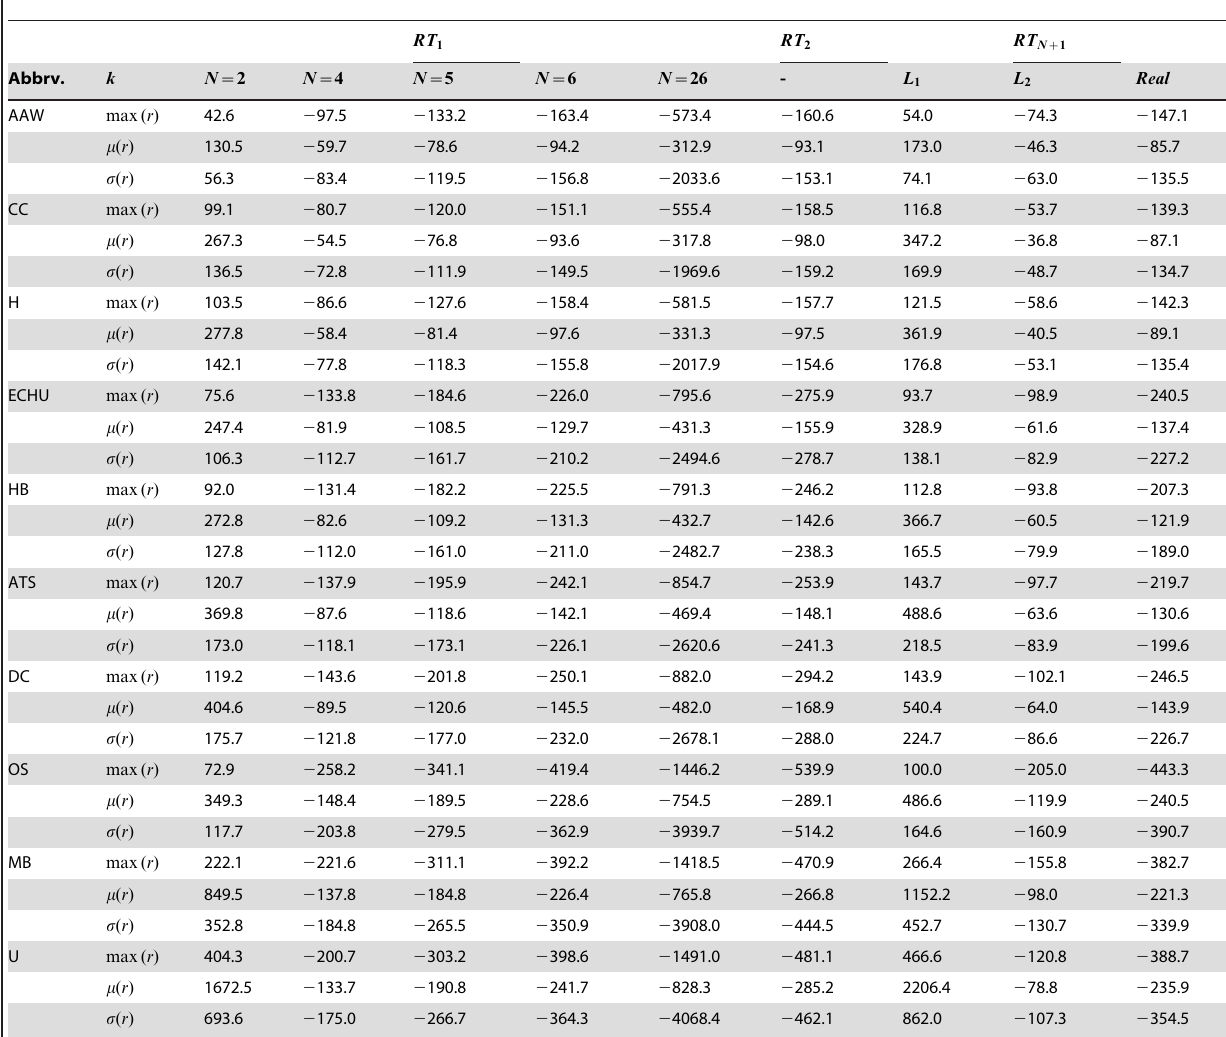
Table 3. Distance to the mean in standard